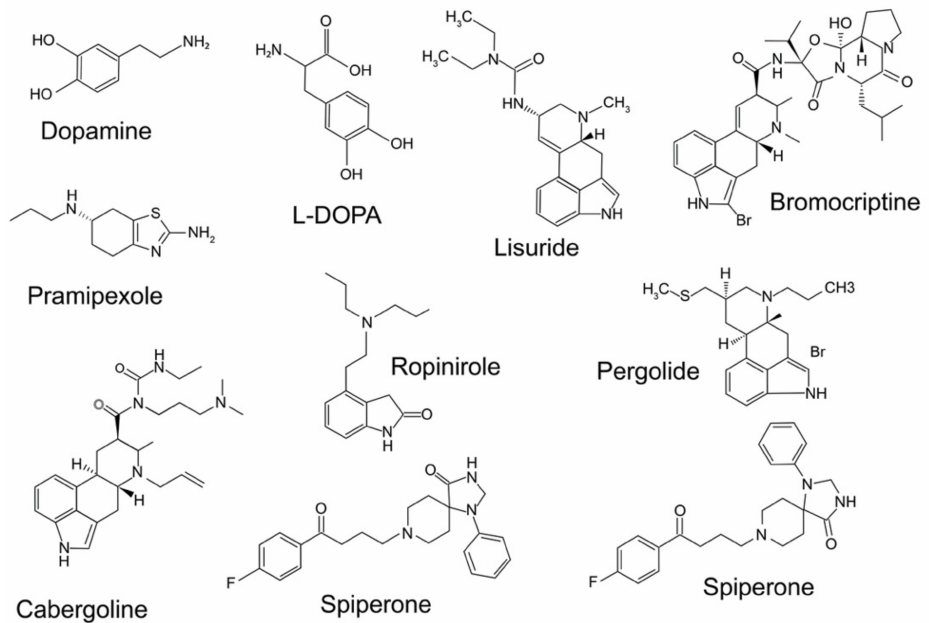
Figure 2. Structure of some important pharmacological agents for dopamine receptors, including dopamine and L